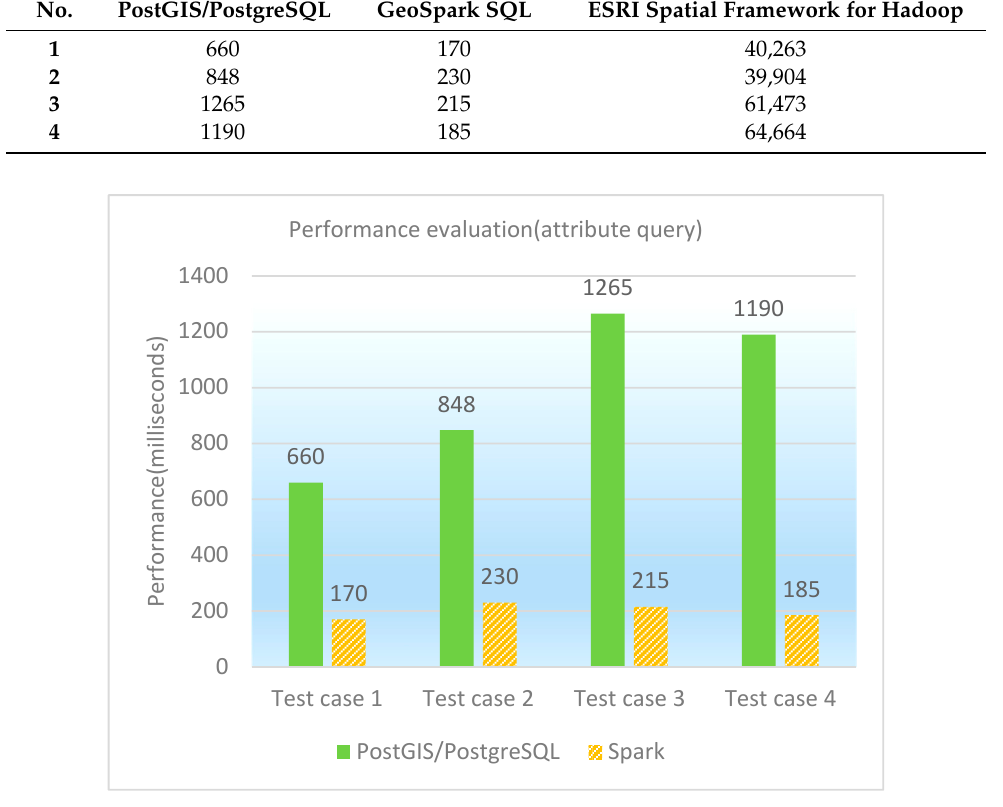
Table 6. Test cases of kNN queries.